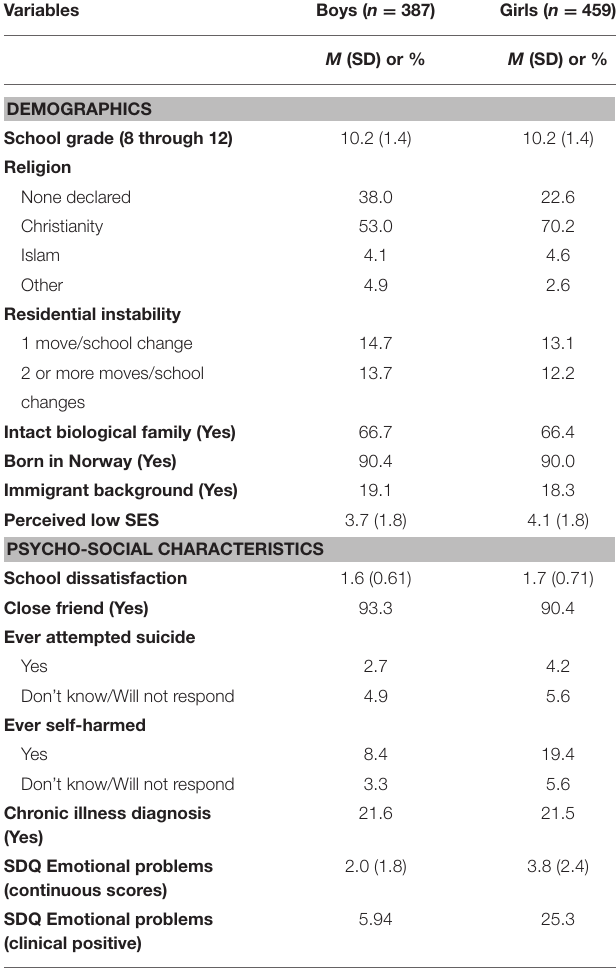
TABLE 1 | Sample characteristics; by